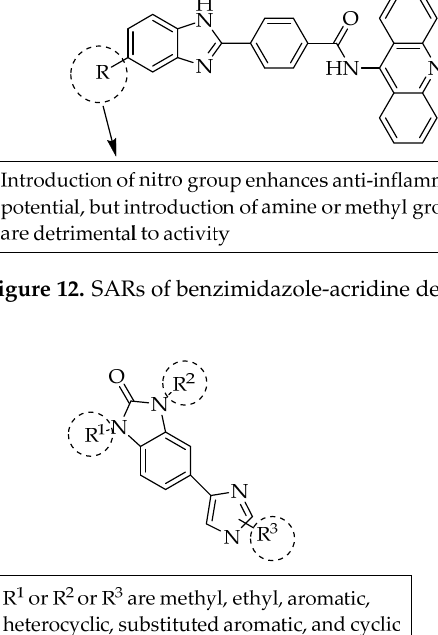
Figure 12. SARs of benzimidazole-acridine derivatives.